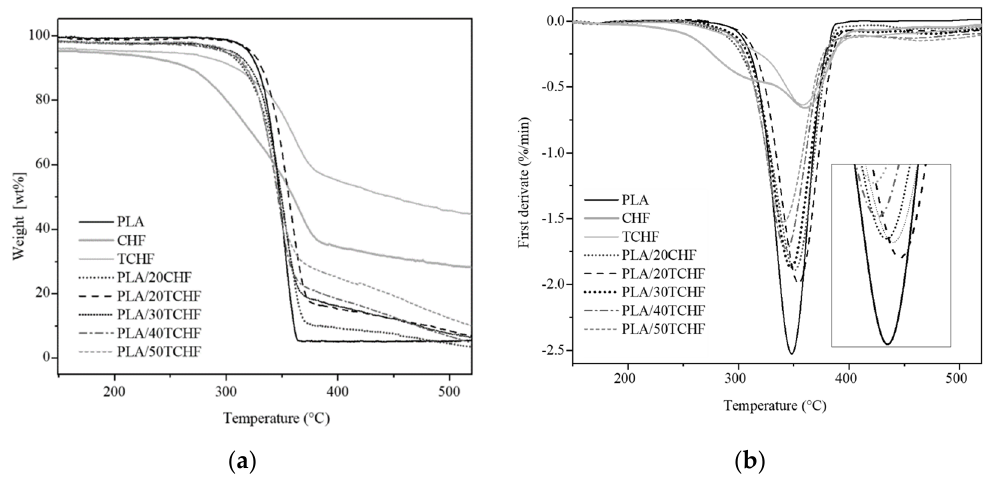
Figure 6. ( a ) Thermogravimetric analysis (TGA) and ( b ) first derivate thermogravimetric (DTG) curves of the injection-molded pieces of polylactide (PLA) with coffee husk flour (CHF) and torrefied coffee husk flour (TCHF). Table 4. Main thermal degradation parameters of the injection-molded pieces of polylactide (PLA) with coffee husk flour (CHF) and torrefied coffee husk flour (TCHF) in terms of temperature at mass loss of 5 % (T 5% ), degradation temperature (T deg ), and residual mass at 700 °C. Piece T 5% ( ◦ C) T deg ( ◦